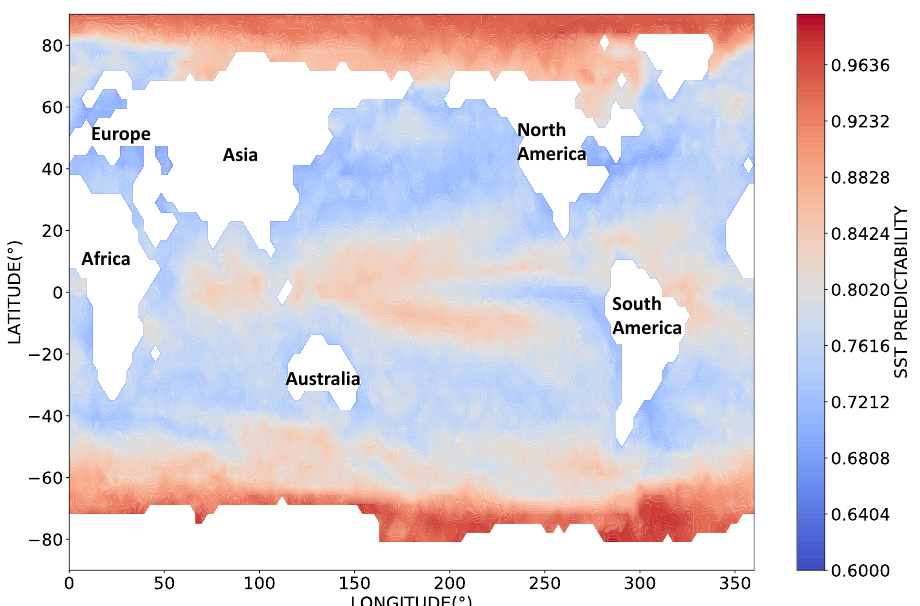
Figure 8. The predictability of global SST within 20 years from 2002 to